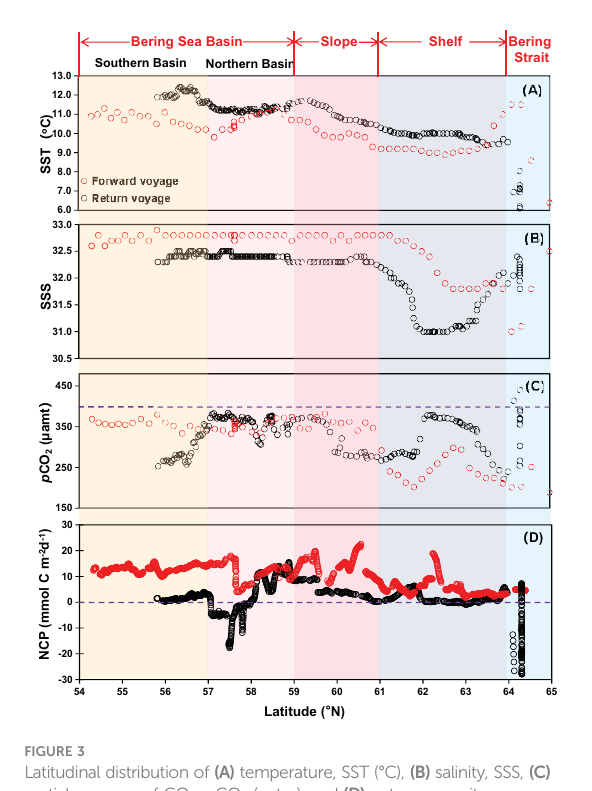
FIGURE 3 Latitudinal distribution of (A) temperature, SST (°C), (B) salinity, SSS, (C) partial pressure of CO 2 , p CO 2 (µatm), and (D) net community production, NCP (mmol C m -2 d -1 ) during the forward voyage in July (red circles) and the return voyage in September (black circles). The blue dashed line in (C) indicates the average atmospheric p CO 2 level of 395 m atm during the cruise; in (D) , it indicates the NCP of 0 mmol C m -2 d -1 . Regions from 54°N to 57°N (the Southern Basin) and from 57°N to 59°N (the Northern Basin) are merged as the Bering Sea